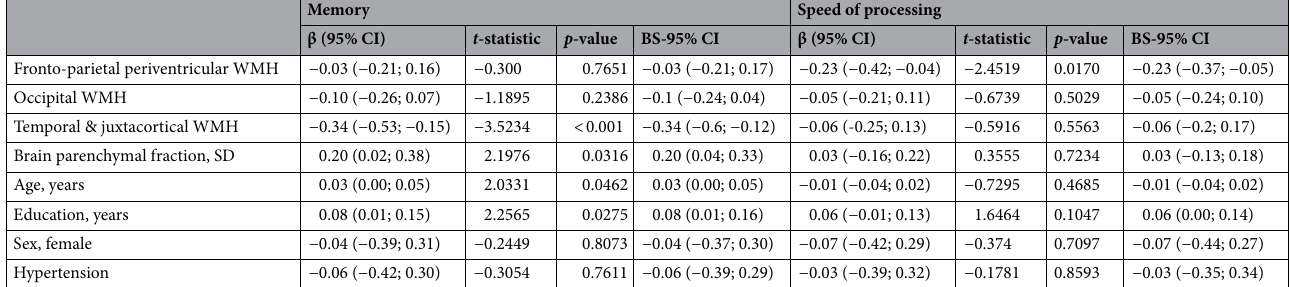
Table 1. Multivariate regression models showing the relationship between WMH and cognitive domains after adjusting for potential confounders. Multiple linear regression models showing the relationship between WMH components and episodic memory and speed of processing after controlling for potential confounders (brain parenchymal fraction, age, education, sex and hypertension). Values indicate β estimates with 95% confidence intervals, t -statistic, p -values and bootstrapped confidence intervals. BS bootstrap, CI confidence interval, SD standard deviation, WMH white matter